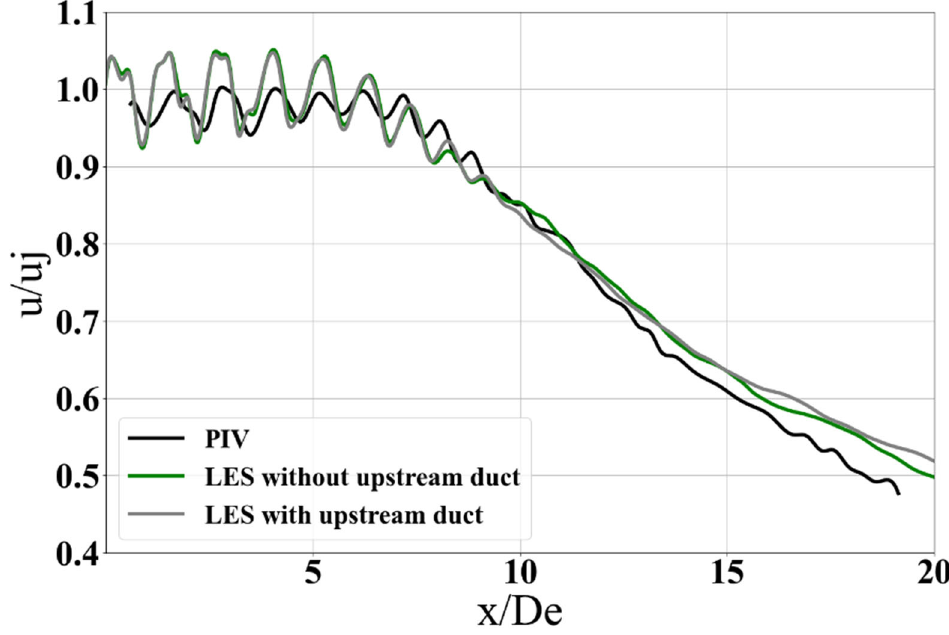
Figure 18 . Jet centerline velocity comparison with PIV data from [60]—LES with and without up ‐ stream duct.